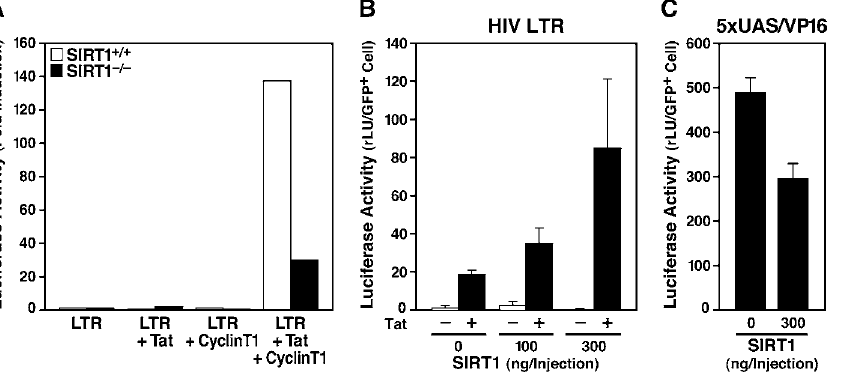
Figure 4. Impaired Tat Transcriptional Activity in Murine SIRT1 (cid:1) / (cid:1) Cells (A) Nuclear microinjection of HIV LTR luciferase, RSV-Tat, and a human cyclinT1-expressing construct into MEFs derived from SIRT þ / þ or SIRT (cid:1) / (cid:1) mice. In all experiments, a fixed amount of DNA was injected by adding the empty vector control. Cells were coinjected with CMV-GFP, and the luciferase activity per GFP-positive cell was calculated. An average of two injections is shown. (B) The HIV LTR luciferase construct together with RSV-Tat and the cyclinT1-expressing construct were coinjected into SIRT (cid:1) / (cid:1) MEFs in the presence of increasing amounts of a plasmid expressing human SIRT1. The average of three experiments is shown ( 6 SEM). (C) Coinjection of the human SIRT1 expression vector together with the 5xUAS luciferase construct containing five Gal4 binding sites upstream of the thymidine kinase promoter and a Gal4-VP16 expression plasmid into SIRT1 (cid:1) / (cid:1) MEFs. The average of three experiments is shown ( 6 SEM). DOI: 10.1371/journal.pbio.0030041.g004